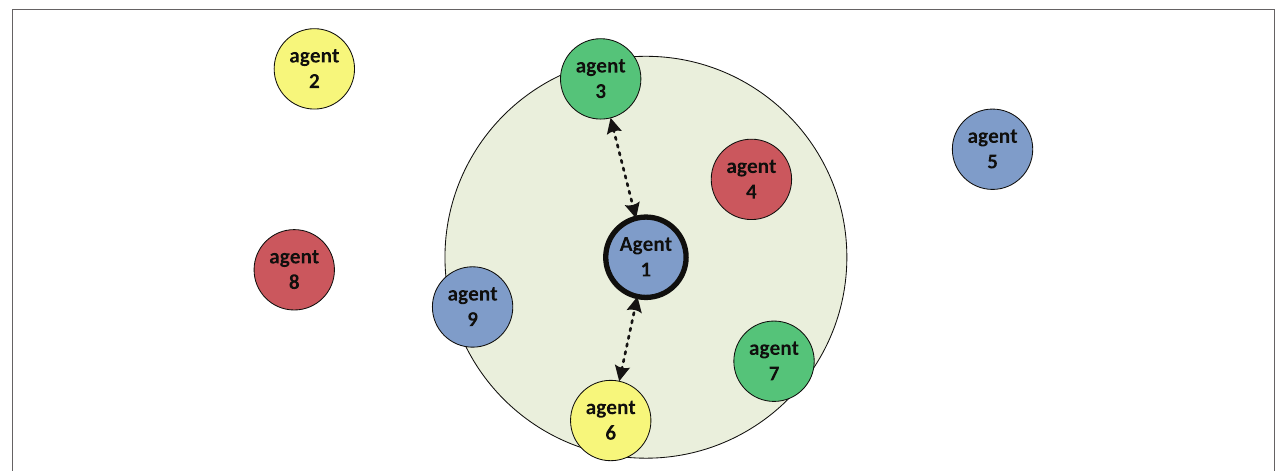
FigUre 4 | example of the environment with some agents and the neighborhood for agent 1 .